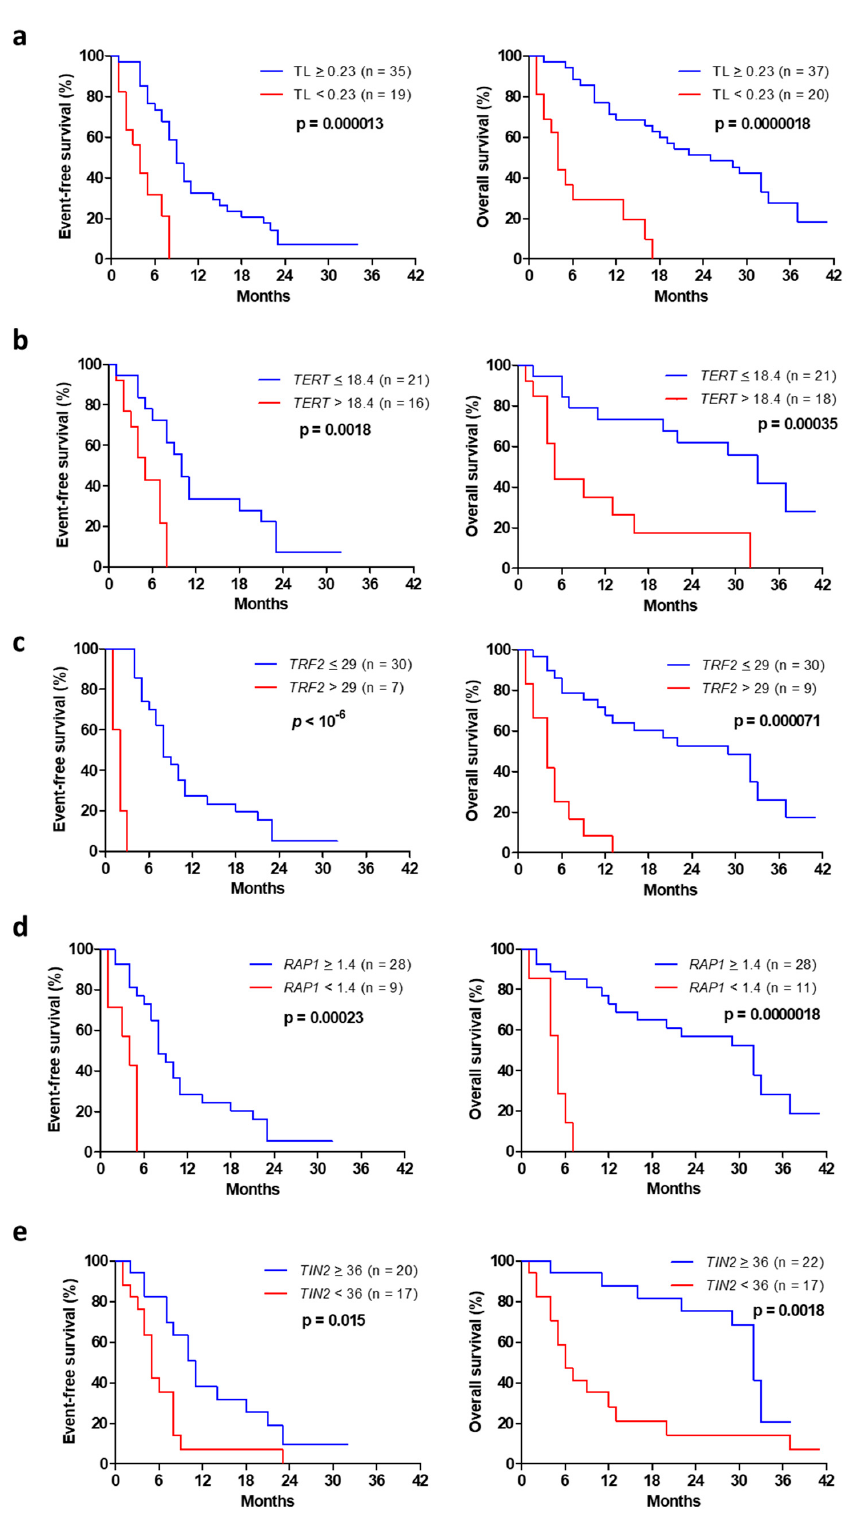
Figure 2. Event-free (left) and overall (right) survival from the date of diagnosis in advanced NSCLC as a function of telomere length ( a ), TERT expression ( b ), TRF2 expression ( c ), RAP1 expression ( d ) and TIN2 expression ( e ).